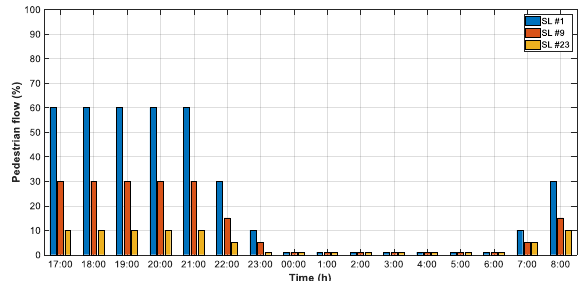
Figure 18. Pedestrian flow distribution.